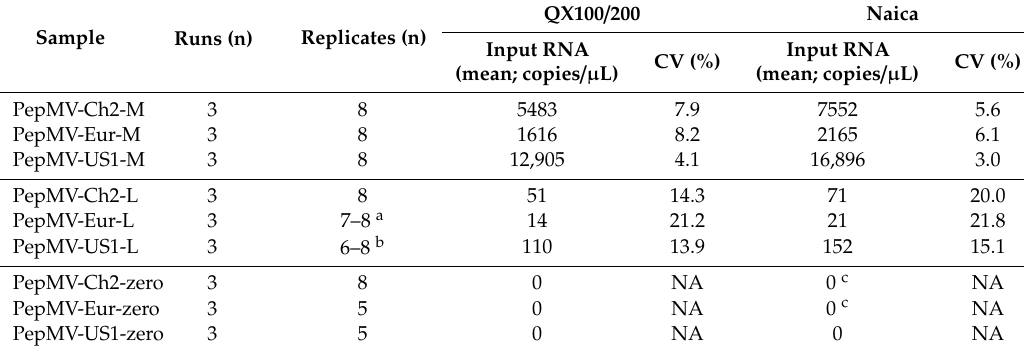
Table 2. Reproducibility of the RT-dPCR assays for PepMV